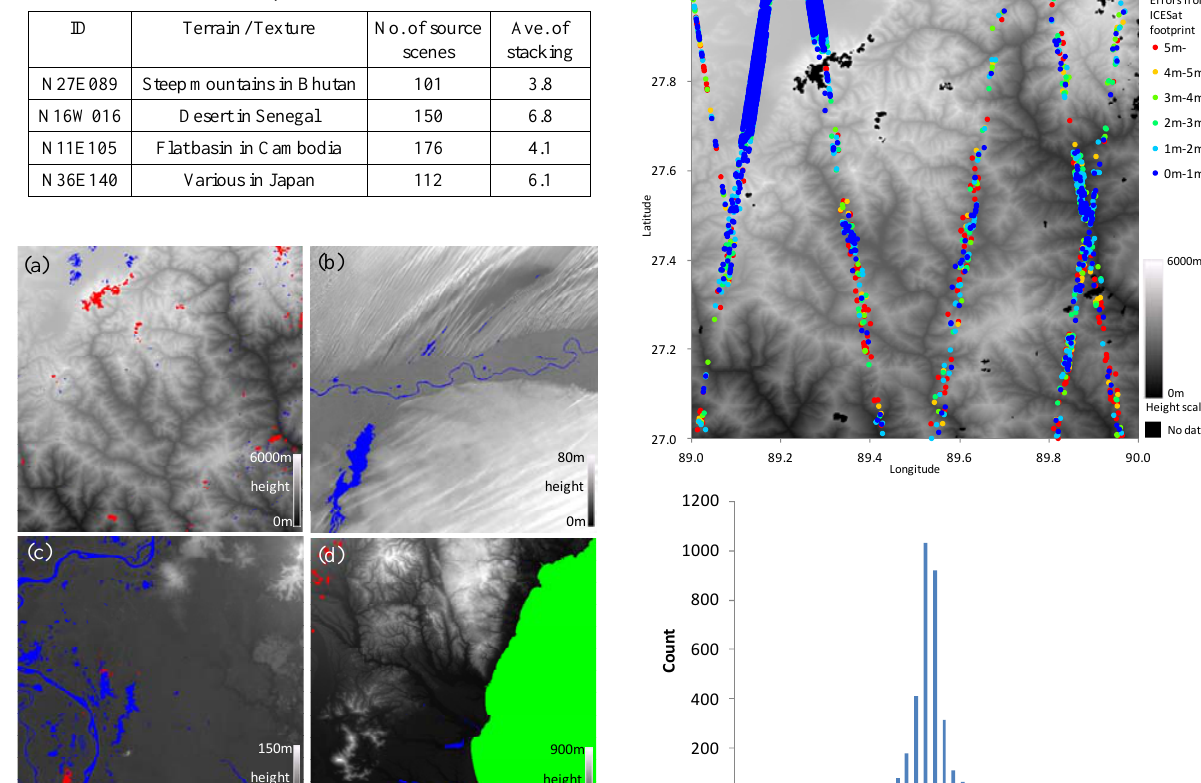
Table 2. Basic specifications of test tiles